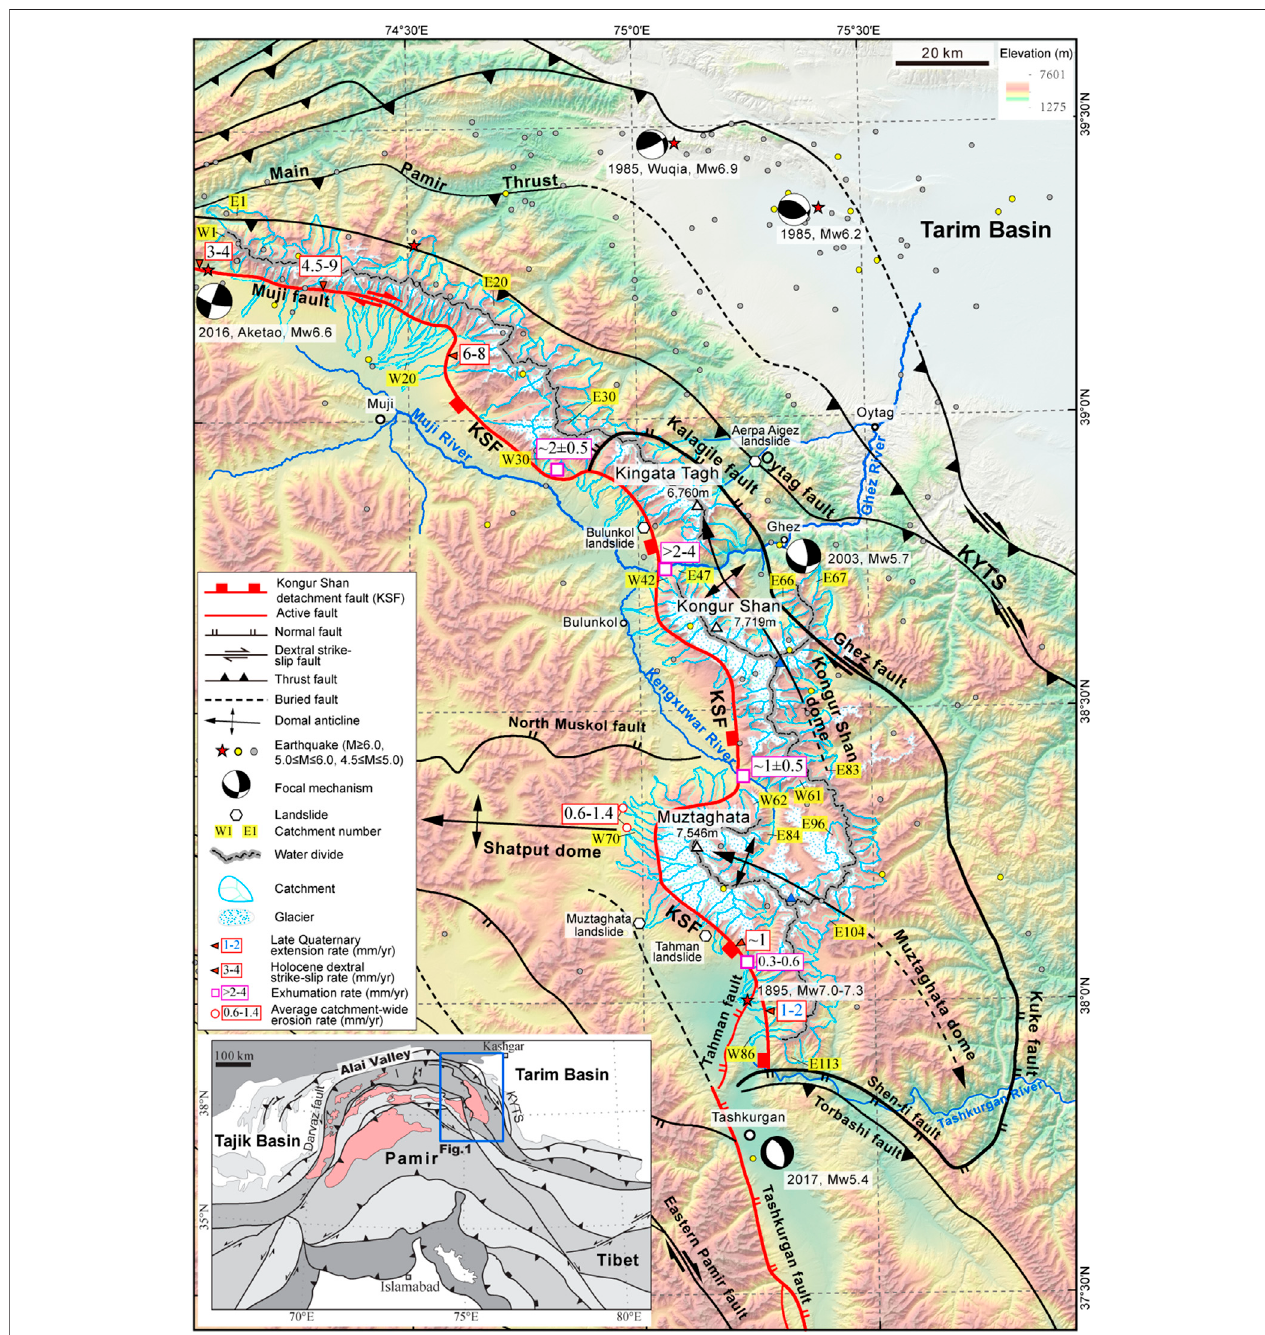
FIGURE 1 | Topography of eastern Pamir and southwestern Tarim basin with main Cenozoic faults, earthquakes (from the USGS), mountain peaks and drainage basins (W = west and E = east). Inset shows location of study area in central Asia with Cenozoic gneiss domes in pink, modi fi ed from Cowgill (2010), Robinson et al. (2007), Schmidt et al. (2011), and Schwab et al. (2004). Holocene extension rates and strike-slip rates are from Chevalier et al. (2011), Chevalier et al. (2015) and Li et al. (2019).Long-term exhumation ratesofthedomes arefrom Arnaud et al.(1993),Cao et al.(2013a), Robinson et al.(2010), and Thiedeet al.(2013). Averagebasin- wide erosion rates are from Seong et al. (2009a). The hexagons show the location of landslides reported by Yuan et al. (2013). KSF: Kongur Shan normalfault; KYTS: Kashgar-Yecheng transfer system.